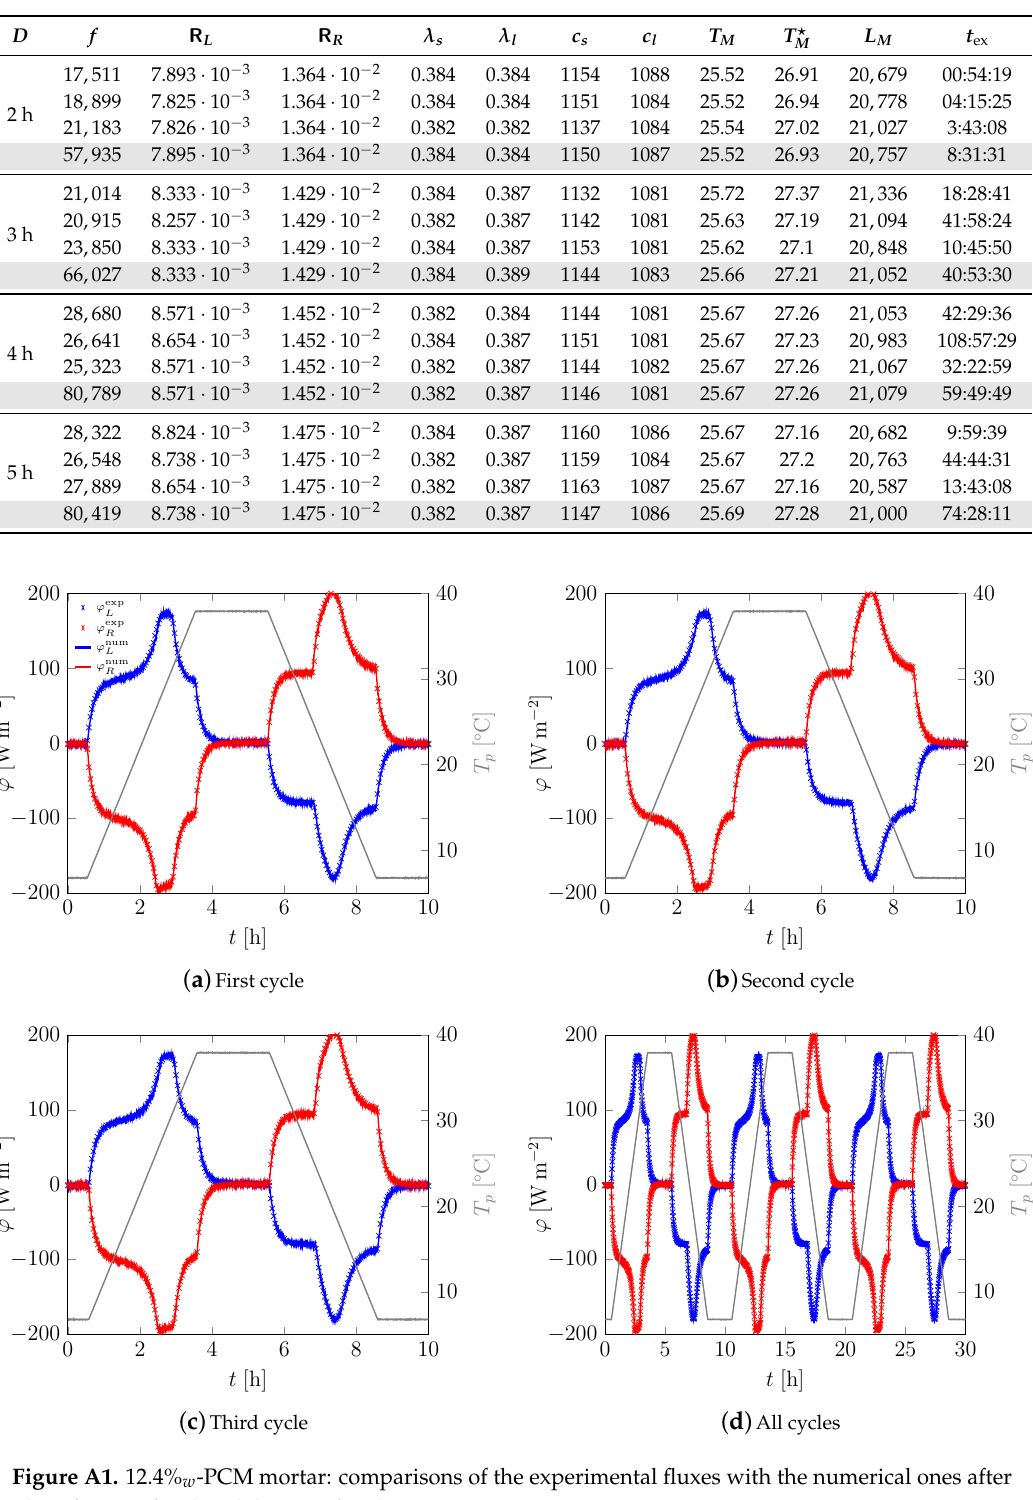
Table A3. 22.1% w -PCM mortar: values of the identified parameters for each heating/cooling ramp and for the first, second, third, and all cycles together cases.